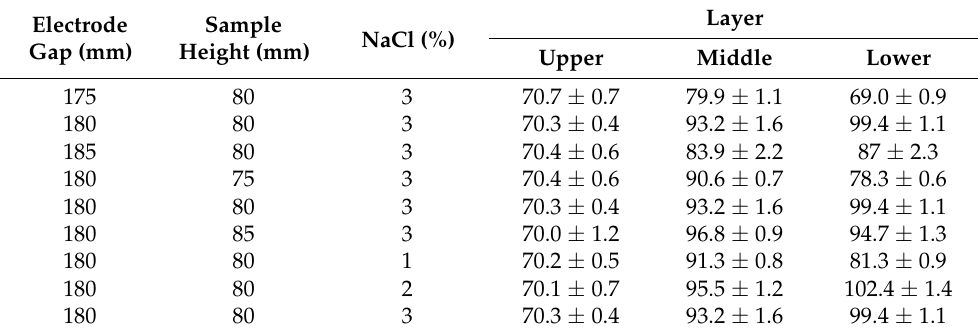
Table 3. The temperature of different layers of samples with different NaCl contents (1, 2 and 3%) under different sample heights (75, 80 and 85 mm) at different electrode gaps (175, 180 and 185 mm) when the temperature of the cold spot reached 70 ◦ C and the temperature was initialized as 25 ◦ C. Electrode Sample NaCl Gap (mm) Height (mm)